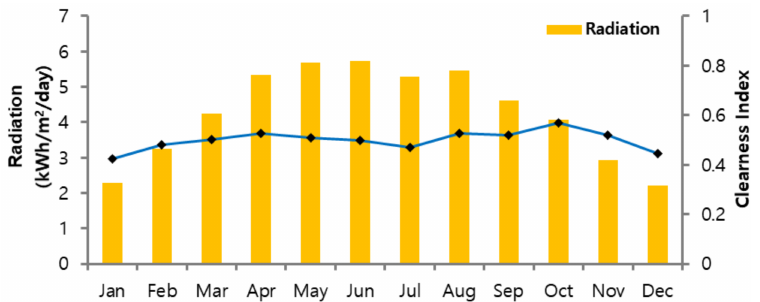
Figure 2. Monthly average solar radiation and clearness index.